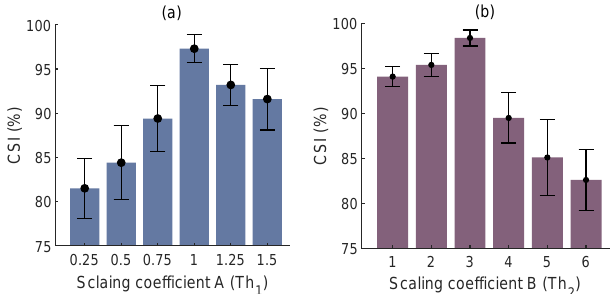
Figure 7. Regulation of constants for trough detection in terms of mean ± std of the CSI. Th 1 ( a ) and Th 2 ( b